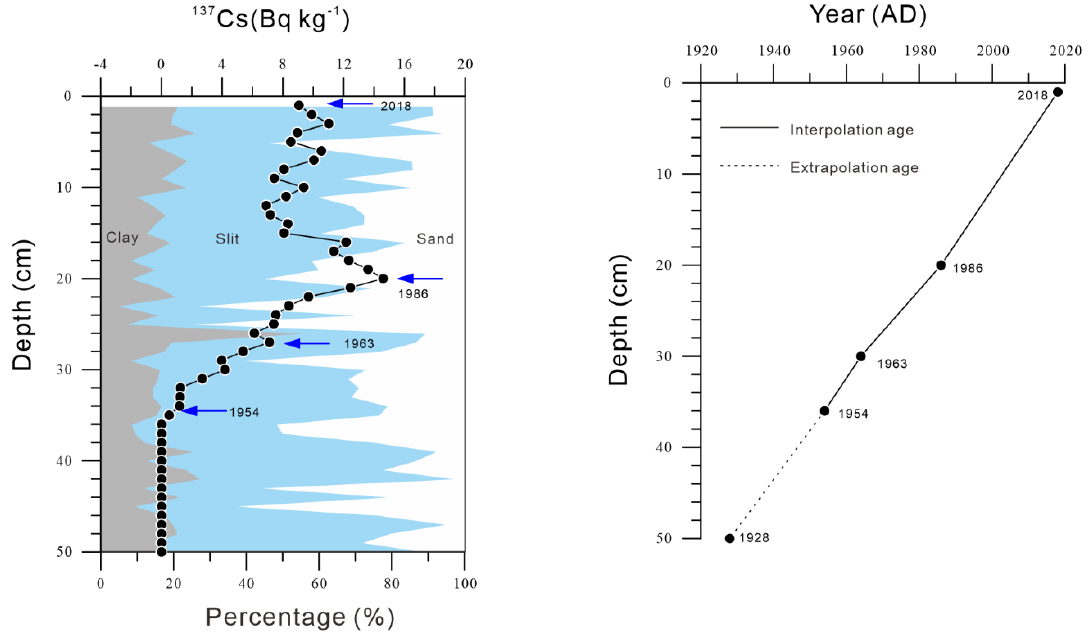
Figure 2. The vertical distribution of 137 Cs specific activity in Lake Ta-Lung-Chi sediments, a mountain lake in the Tian Shan ( left ), and the established chronological record for sediment core TLC01 ( right ). Different colors represent the percentage (%) of clay (gray)/silt (blue)/sand (white) versus depth.